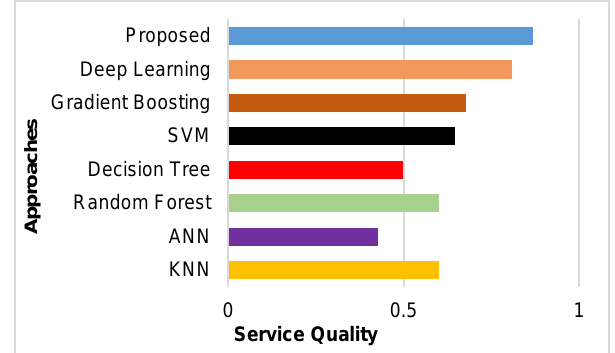
Figure 7. Comparative analysis of service quality.